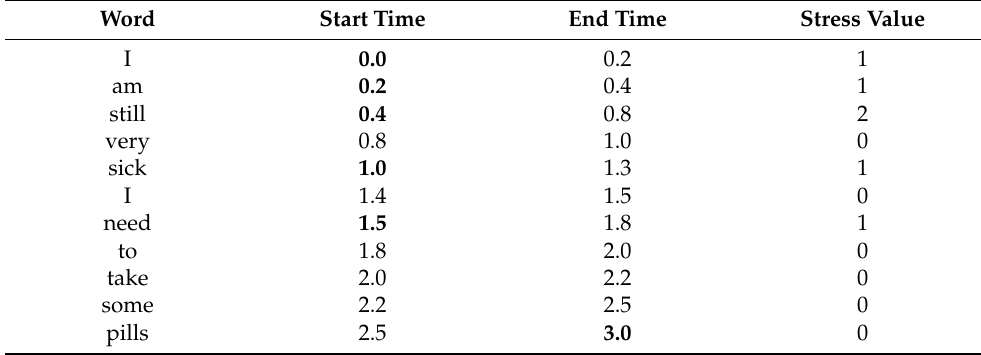
Table 1. Sentence stress pattern in the sentence “I am still very sick. I need to take some pills.” Word